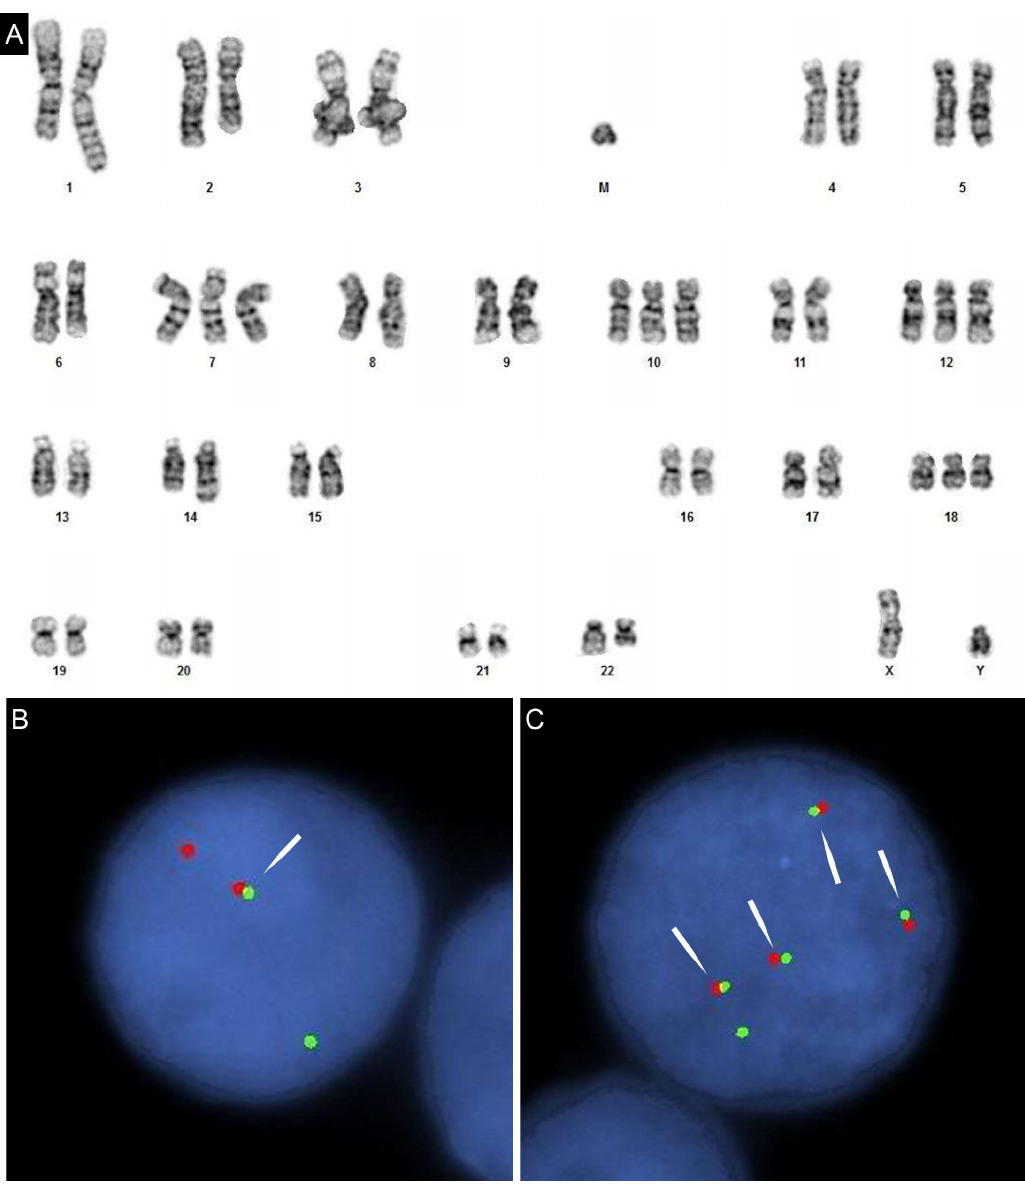
Figure 2. ( A ) Karyotype of DHL with c-MYC / IGL and BCL2 / IGH rearrangements. Clonal evolution related triplication of the derivative (18) t(14;18) highlights the complex additional alterations; ( B ) fluorescent in-situ hybridization (FISH) targeting c-MYC using a flanking break-apart probe set. Fusion (arrow) represents the normal locus. The separated red and green signals indicate c-MYC rearrangement. ( C ) Dual fusion FISH targeting immunoglobin heave chain ( IGH ) (green) and BCL2 (red). One fusion signal represents derivative 14 and the remaining three fusions signals are the oncogenic 18 derivatives (arrows). Absence of a normal 18 (an isolated red signal) agrees with the karyotype and is likely due to mitotic recombination-based evolution, transferring the fusion site to the original normal homolog, in addition to the more common nondisjunction-based duplication for the third derivative in this etiology.